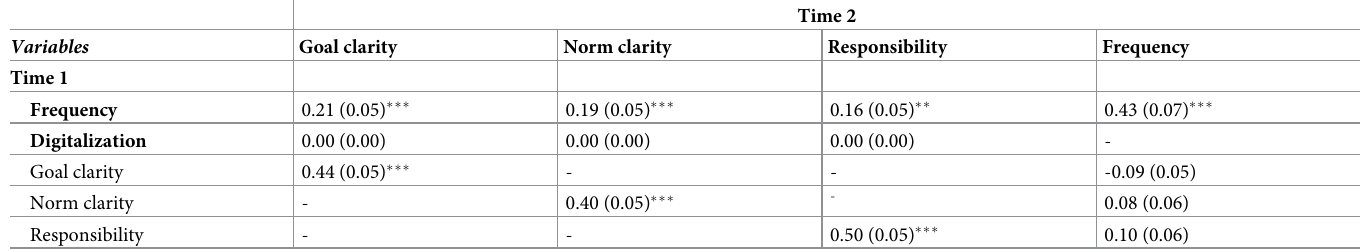
Table 5. Estimates of the structural model in Study 2, with b ( SE ); STDXY standardization from Mplus ( N =